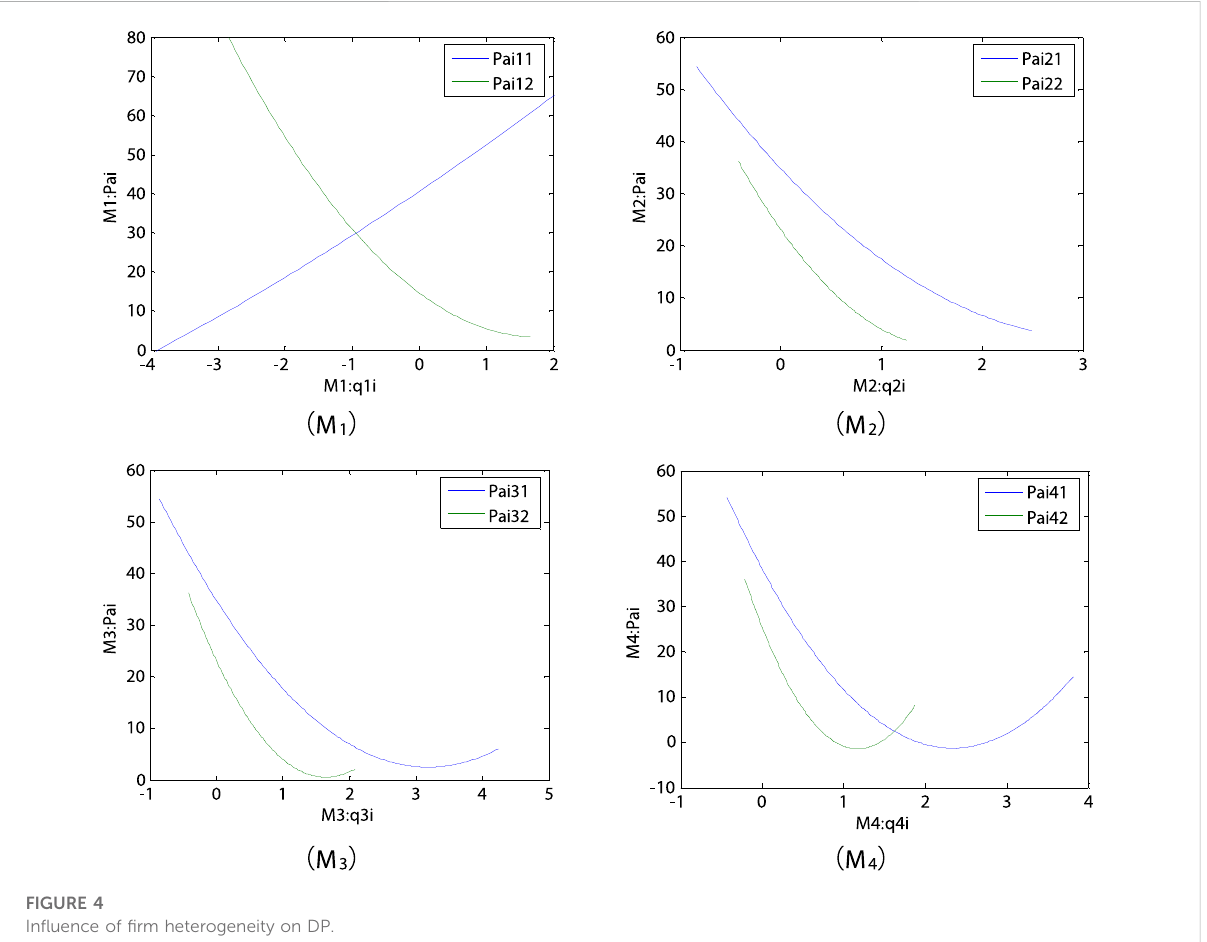
FIGURE 4 In fl uence of fi rm heterogeneity on